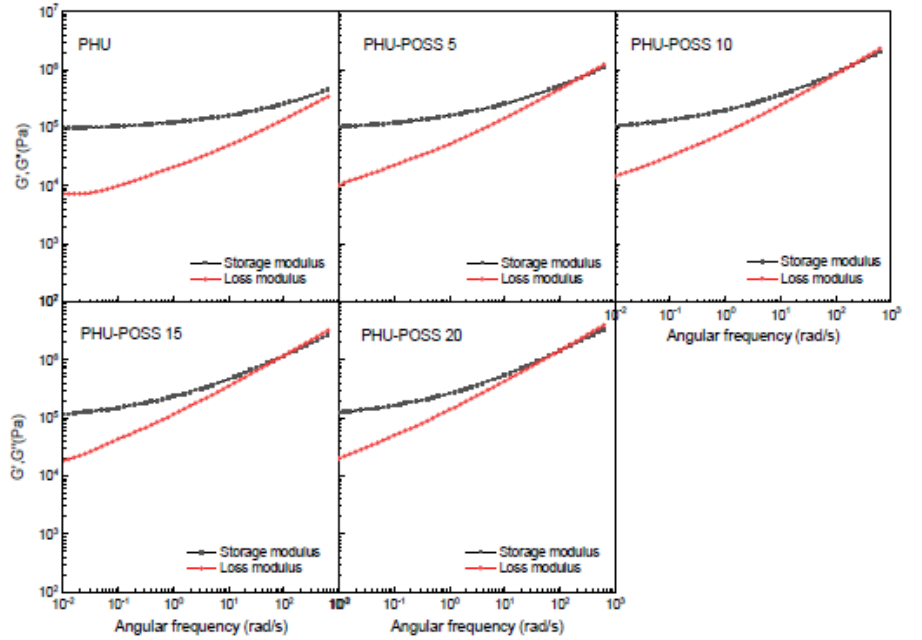
Figure 6. Rheological data of PHU and PHU-POSS nanocomposites with an angular frequency sweep at 80 °C.